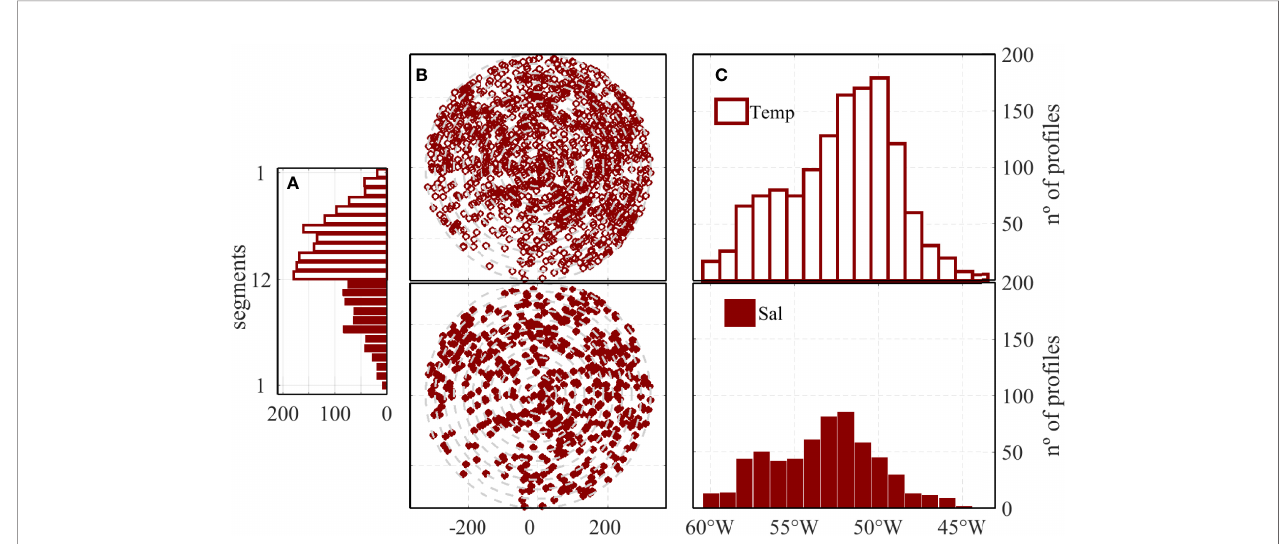
FIGURE 3 | Distribution of the selected IR pro fi les: (A) number of T (upper) and S (lower) pro fi les in 12 equally spaced intervals along the radius of the mean ring, after normalization according to equation 1; (B) spatial distribution of all selected T (upper) and S (lower) pro fi les, after normalization; and (C) number of T (upper) and S (lower) pro fi les for different longitudinal bands.